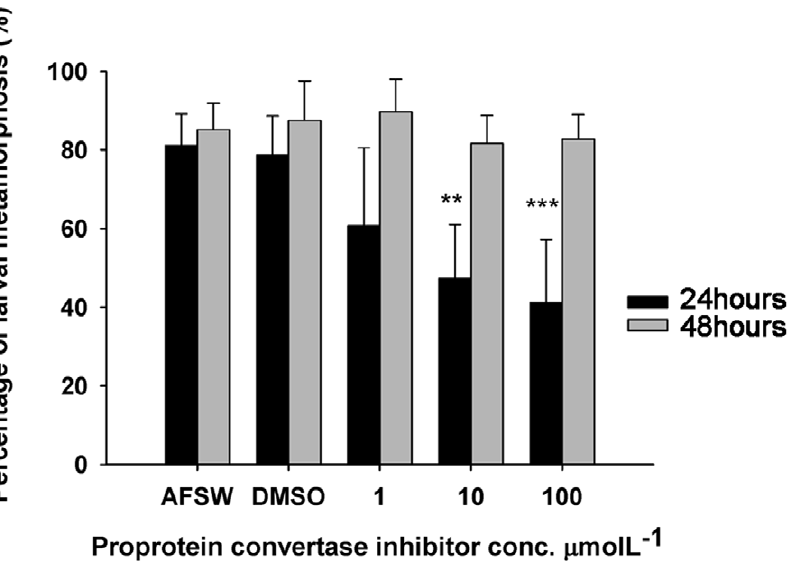
Figure 11. Proprotein convertase inhibitor bioassay result. Autoclaved filtered seawater (AFSW) and 0.1% DMSO served as positive control. Error bar represents mean 6 SD for three biological replicates. Asterisks indicate significant difference detected by one-way ANOVA comparing the treatments to the positive control (Tukey test, ** p , 0.01 and *** p , 0.001).